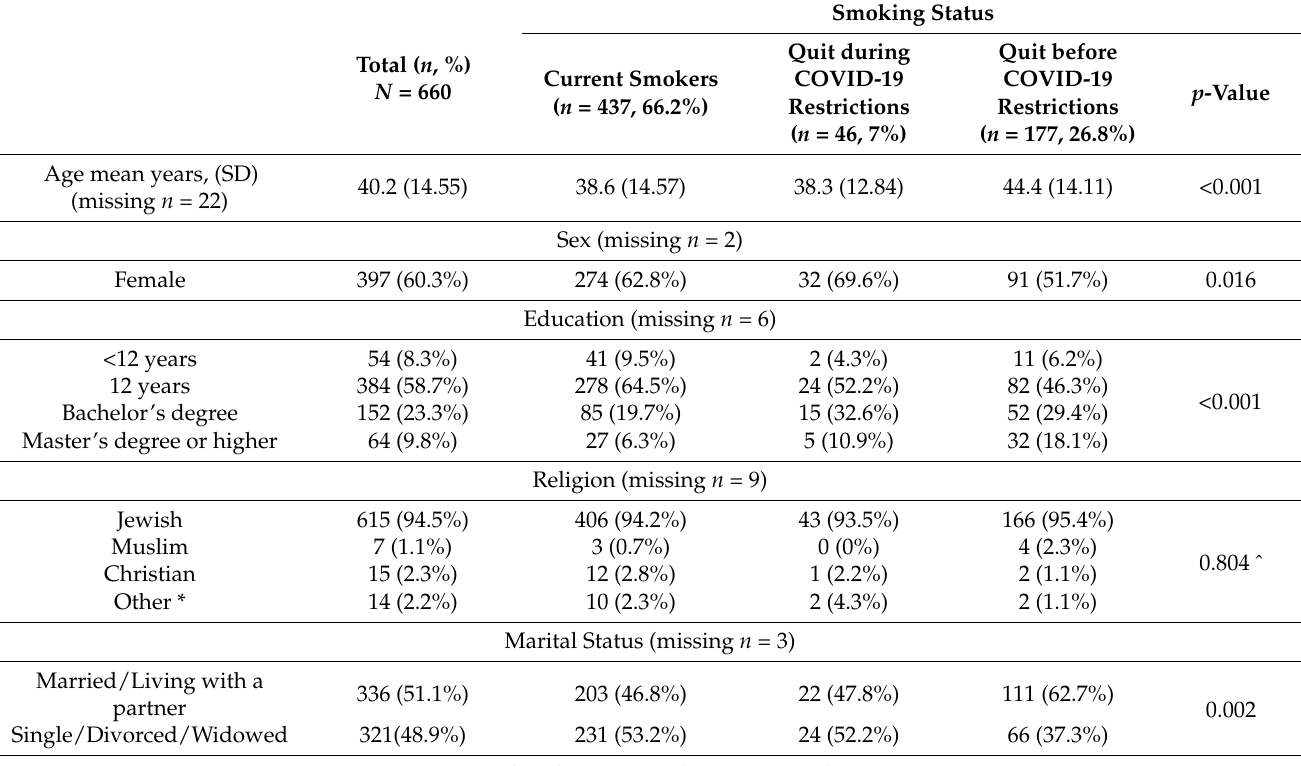
Table 1. Sociodemographic characteristics of the total sample ( N = 660) and by smoking status, Israel, 2020.